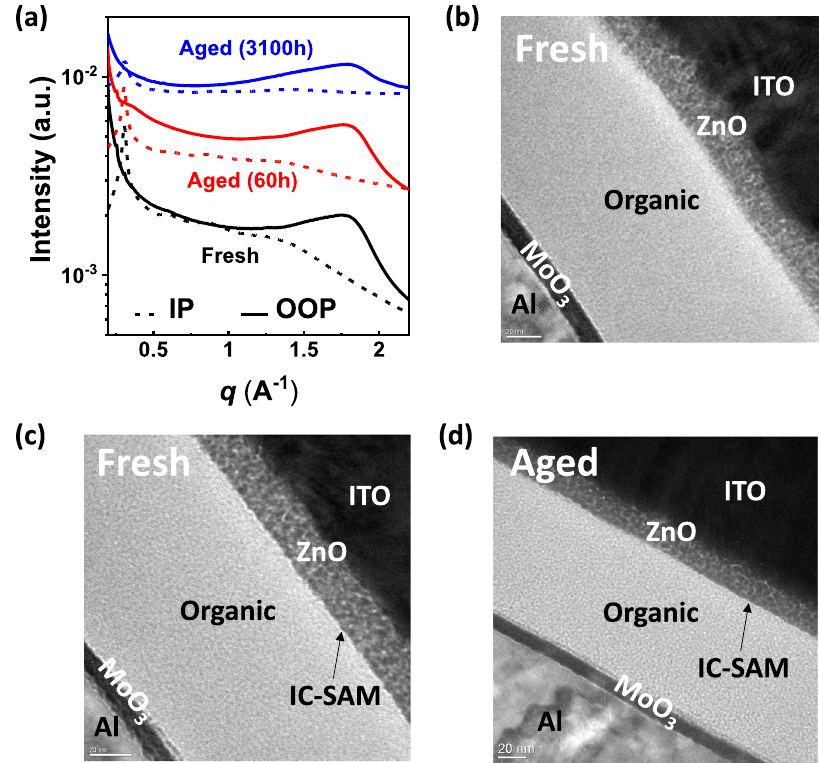
Fig. 3 GIWAXS characterization and TEM images. a In-plane (dotted line) and out-of-plane (solid line) sector-averaged pro fi les extracted from grazing incidence wide-angle X-ray scattering (GIWAXS) patterns; q is the scattering vector. b Transmission electron microscope (TEM) image of cross-sectional slices of a fresh PCE-10:BT-CIC device without an interface buffer layer. c Fresh PCE-10:BT-CIC device with an IC-SAM layer inserted at the